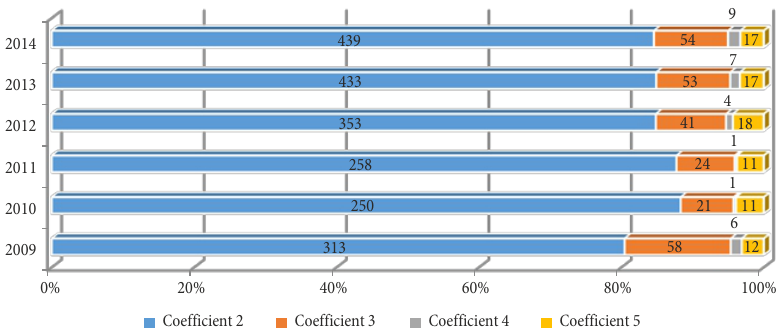
Fig. 2. Use of the local coefficient by municipalities between 2009 and 2014 Source: Tax administration 2015, own processing